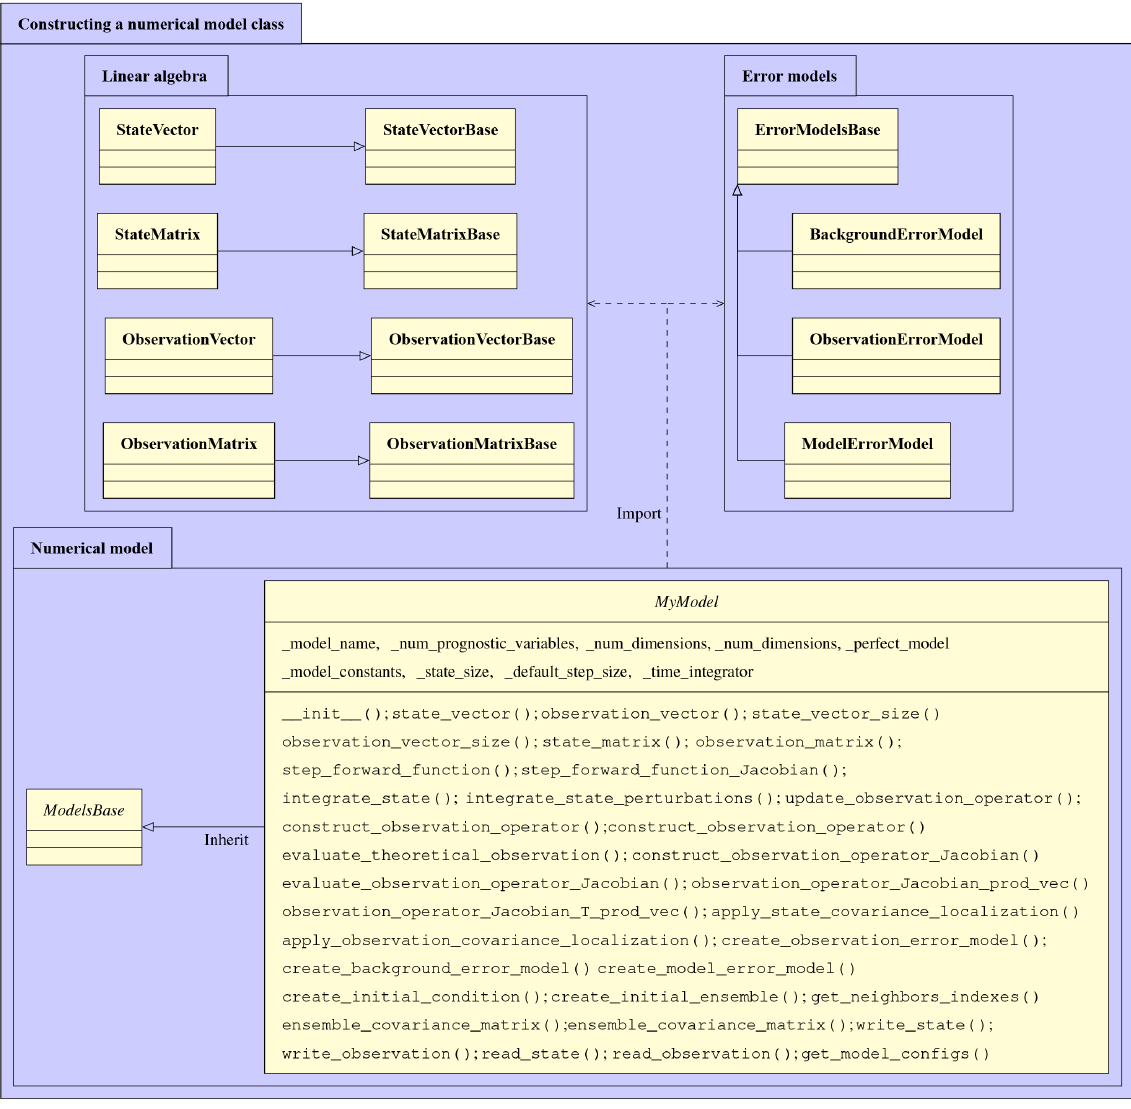
Figure 17. Illustration of a numerical model class named MyModel and relations to the linear algebra and error models classes. A dashed arrow refers to an “import” relation, and a solid arrow represents an “inherit”